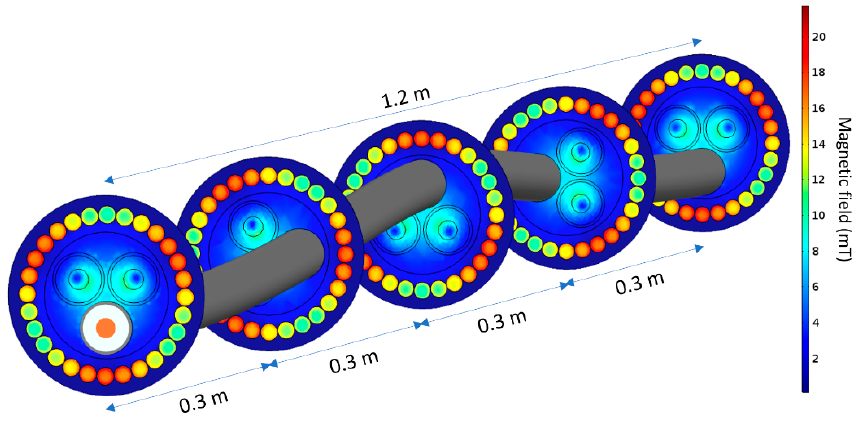
Figure 5. Magnetic field magnitude in different slices spaced a distance equal to the CP of Cable 1.